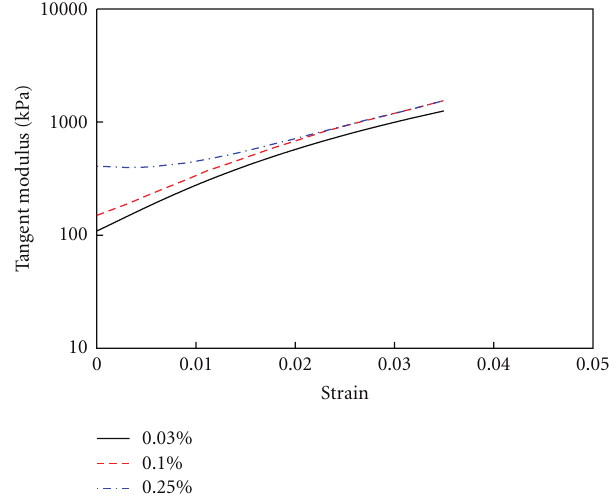
Figure 4: Average tangent modulus of the collagen sca ff olds with 0.03%, 0.1%, and 0.25% GP.